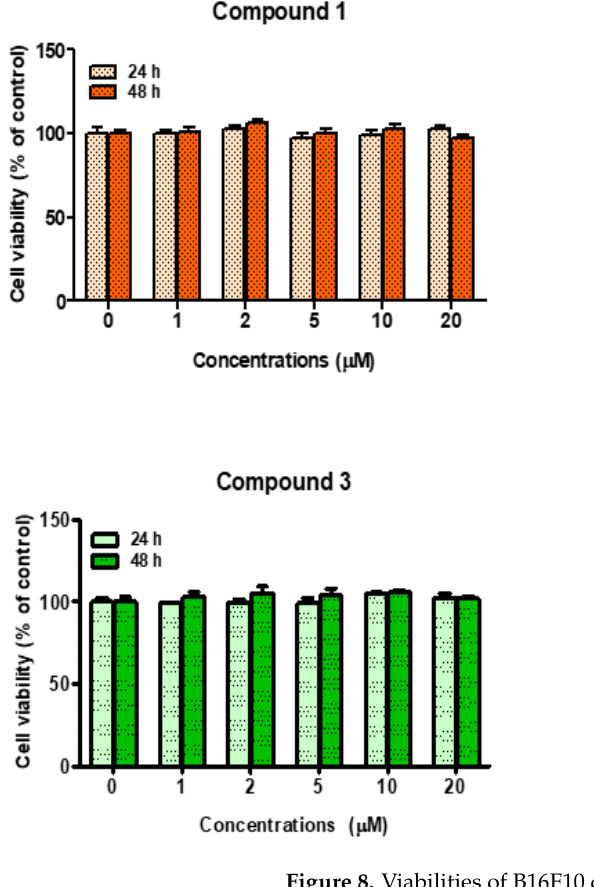
Figure 8. Viabilities of B16F10 cells treated with analogs 1 , 2 , 3 , or 6 . Cell viabilities after 24 or 48 h of treatment were assessed using the EZ-Cytox assay at six different concentrations (0, 1, 2, 5, 10, or 20 µM). Results are presented as percentages of non-treated controls and bars show standard errors. All experiments were performed independently in triplicate.